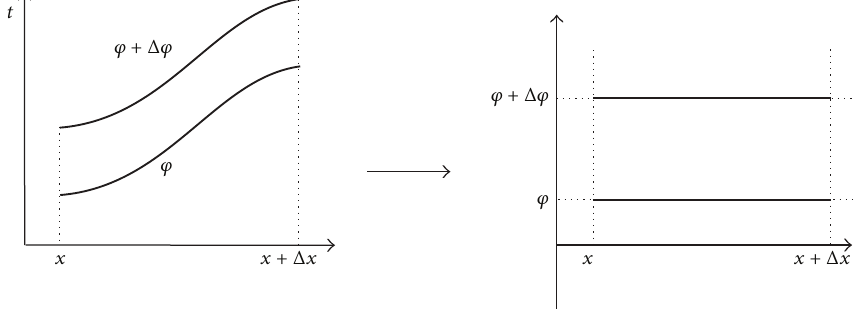
Figure 3: Derivation of mass balance equation in Eulerian and Lagrangian coordinate